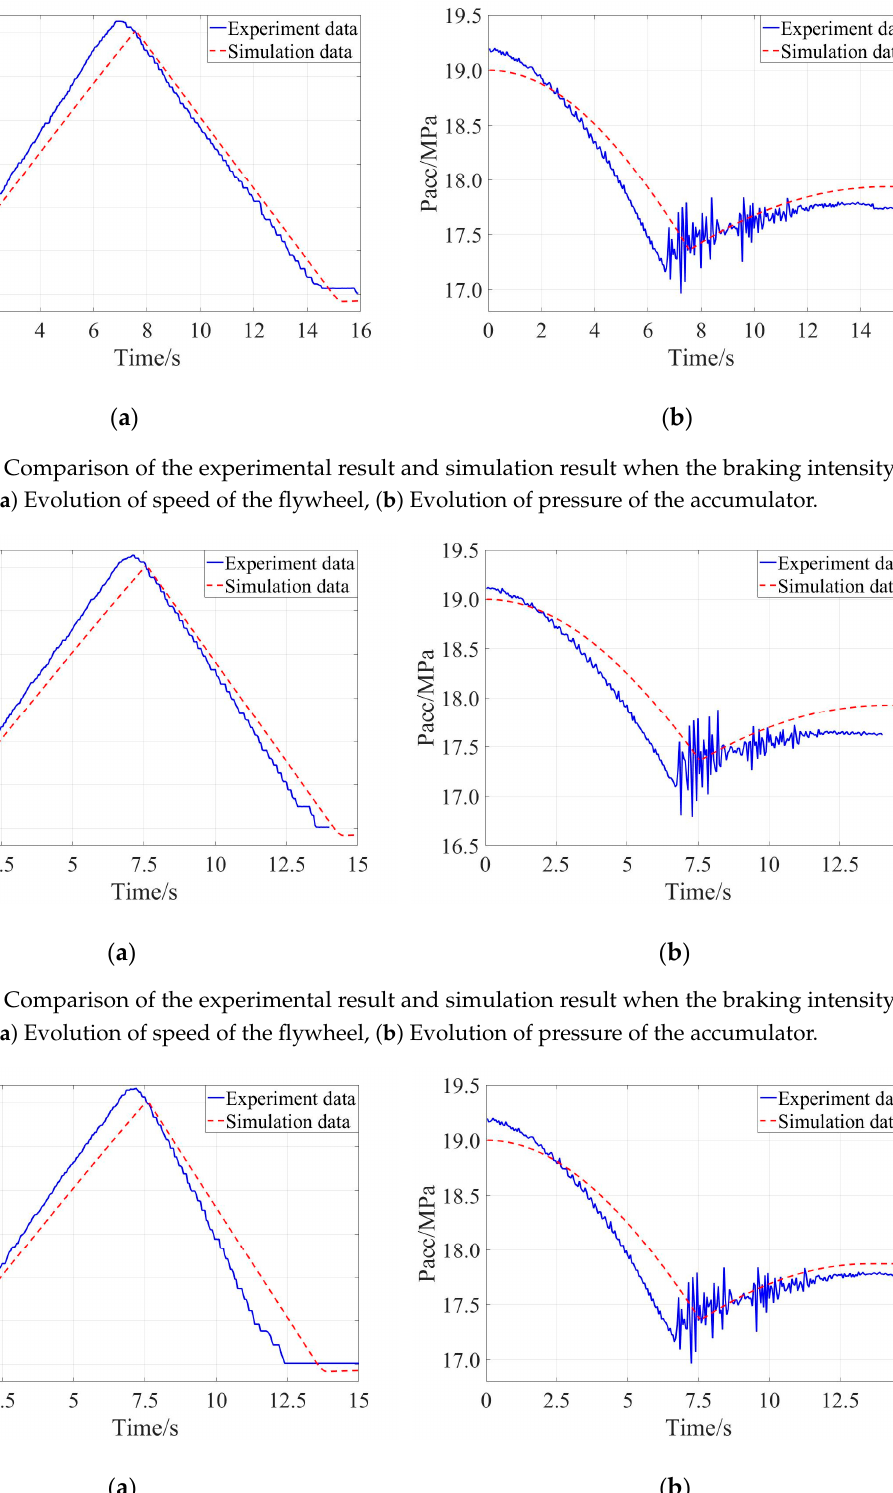
was 0.35: ( a ) Evolution of speed of the flywheel, ( b ) Evolution of pressure of the accumulator.